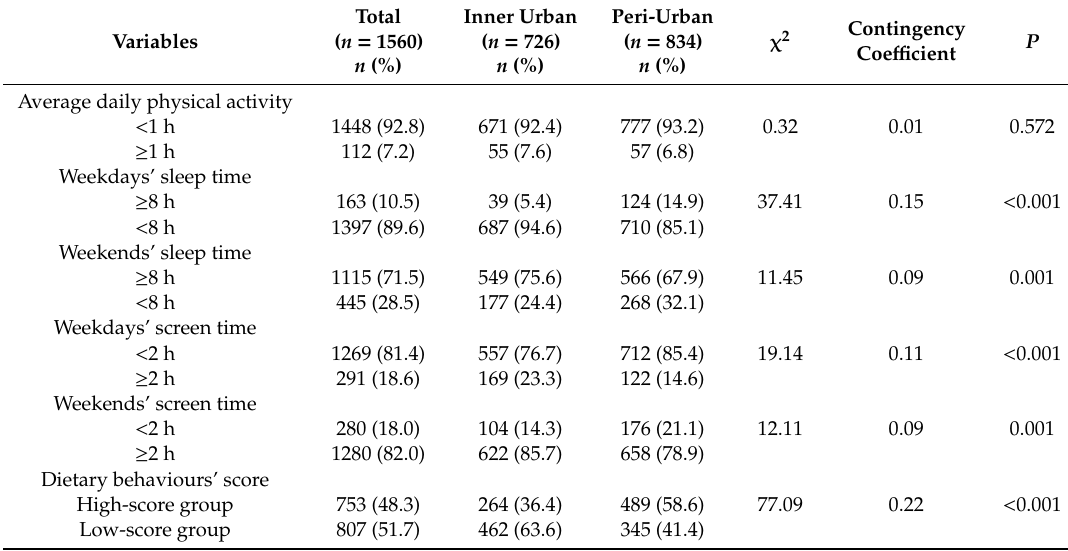
Table 2. The comparison of lifestyle behaviours between IUHSSs and PUHSSs in Chongqing, China ( n =